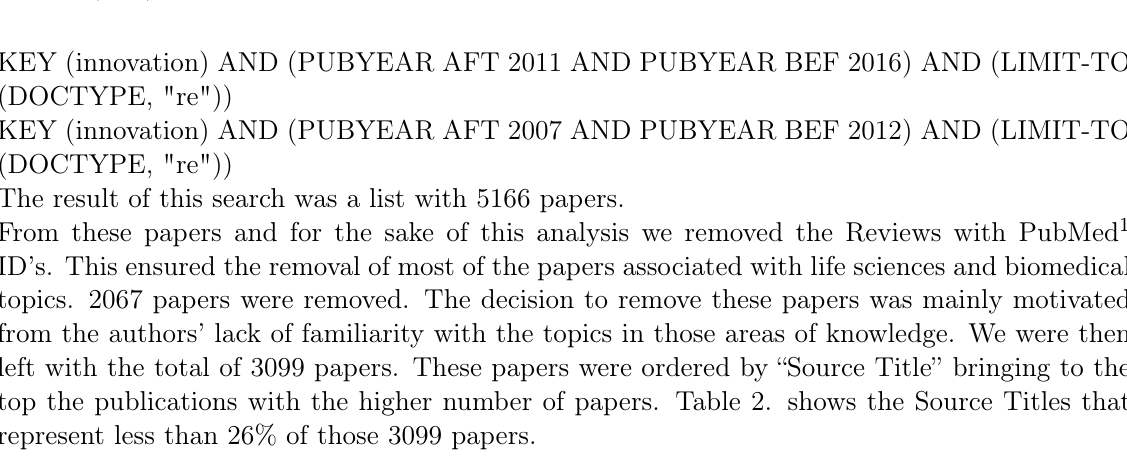
Table 2. Journals representing less than 26% of the total number of Reviews (the H Index was extracted from the Scimago Journal Rank 2